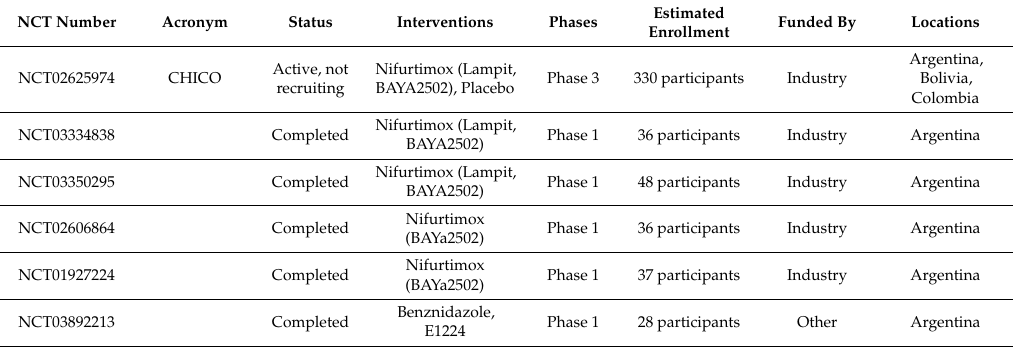
Table 1. Summary of the main clinical trials with studies on drugs for the treatment of Chagas